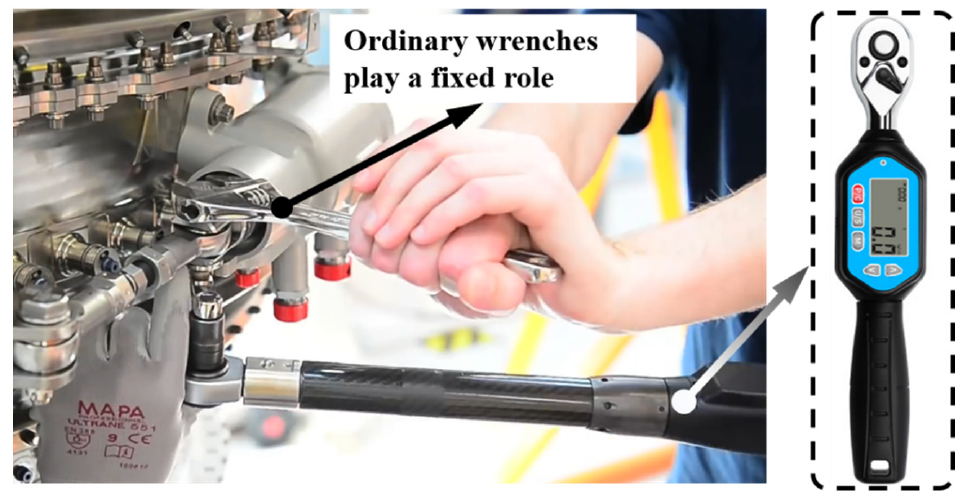
Figure 18. Schematic diagram of a constant-torque wrench [89,90]. Electric wrenches apply accurate tightening torque to the bolts through the self-rotation of the tightening sleeve, and the user only needs to play the role of holding the electric wrench. The most widely used brands, such as Atlas Copco electric wrenches, have a tightening torque accuracy of ± 3% or less. The rotation angle is monitored in real time, and the tightening speed is smooth and adjustable, so the electric wrenches can perform various tightening processes accurately and stably, and the quality consistency of their bolt connections is better, as shown in Figure